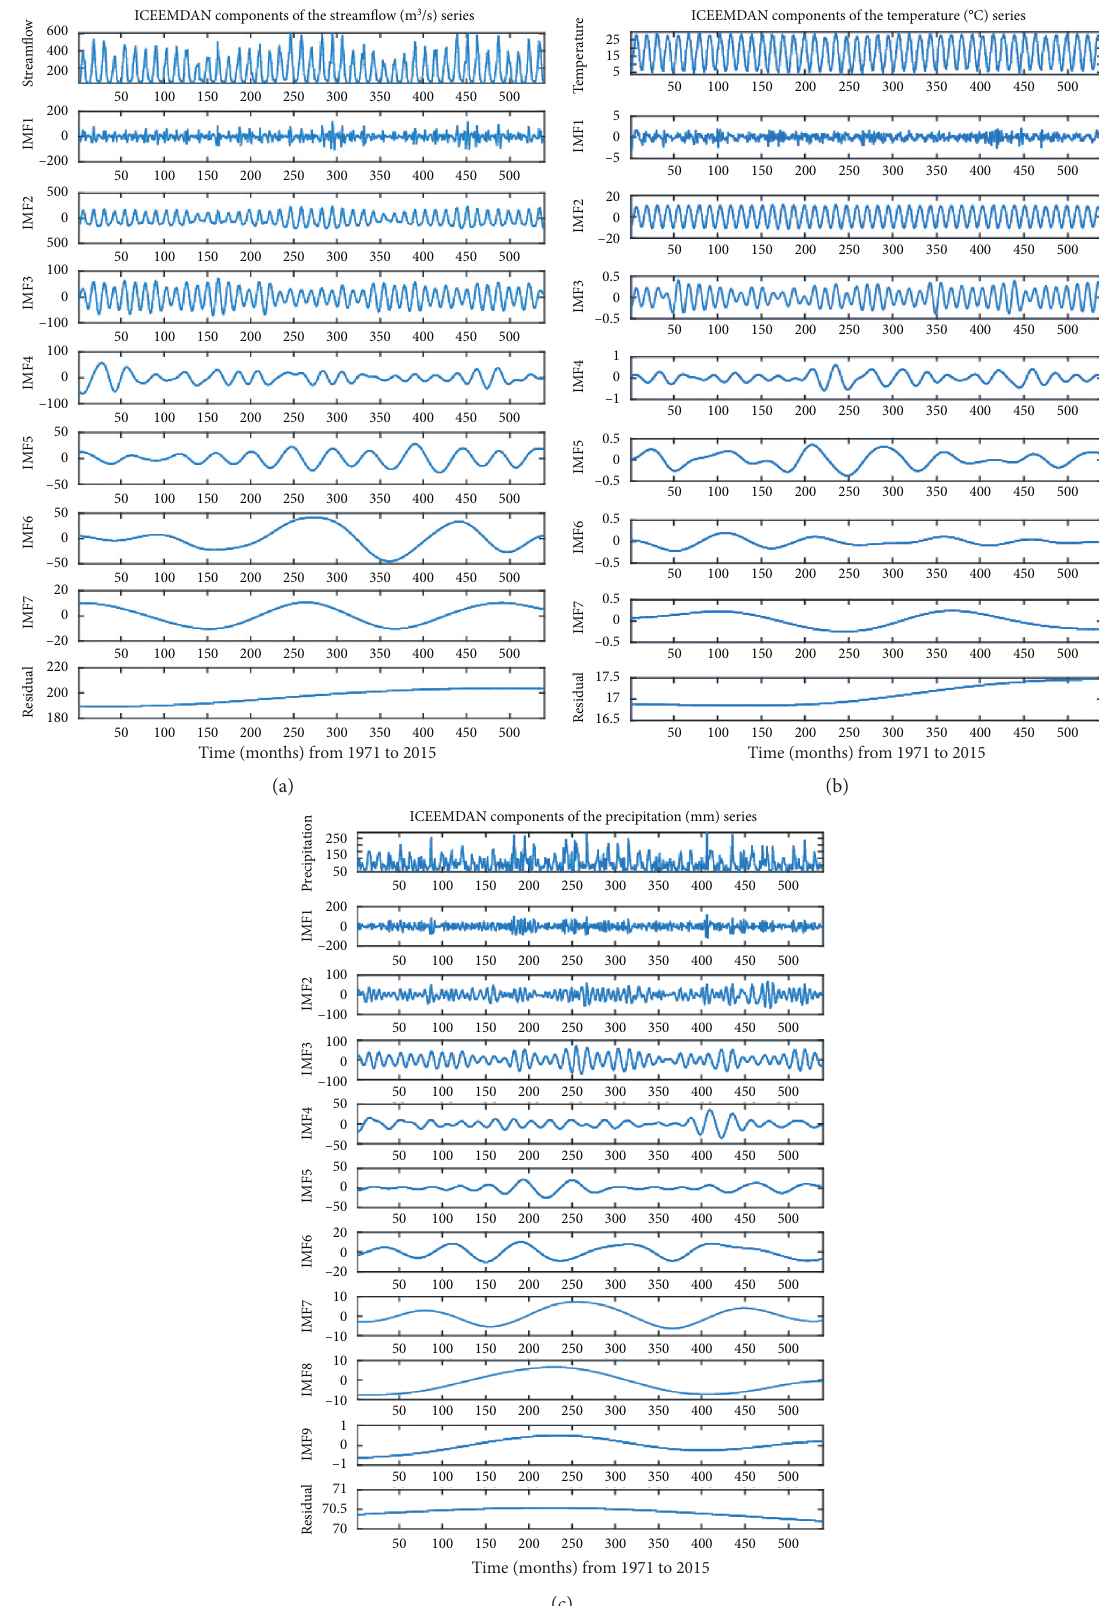
Figure 4: Decomposition of time series by ICEEMDAN. (a) Streamflow. (b) Temperature. (c)